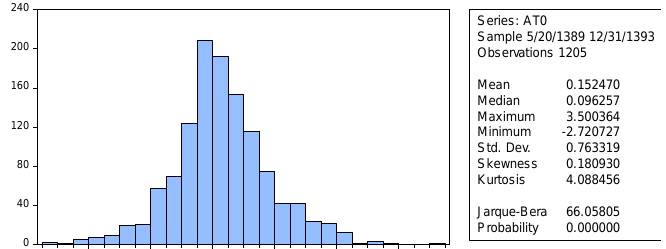
Figure 1. Normal distribution of total return index of Tehran Stock Market